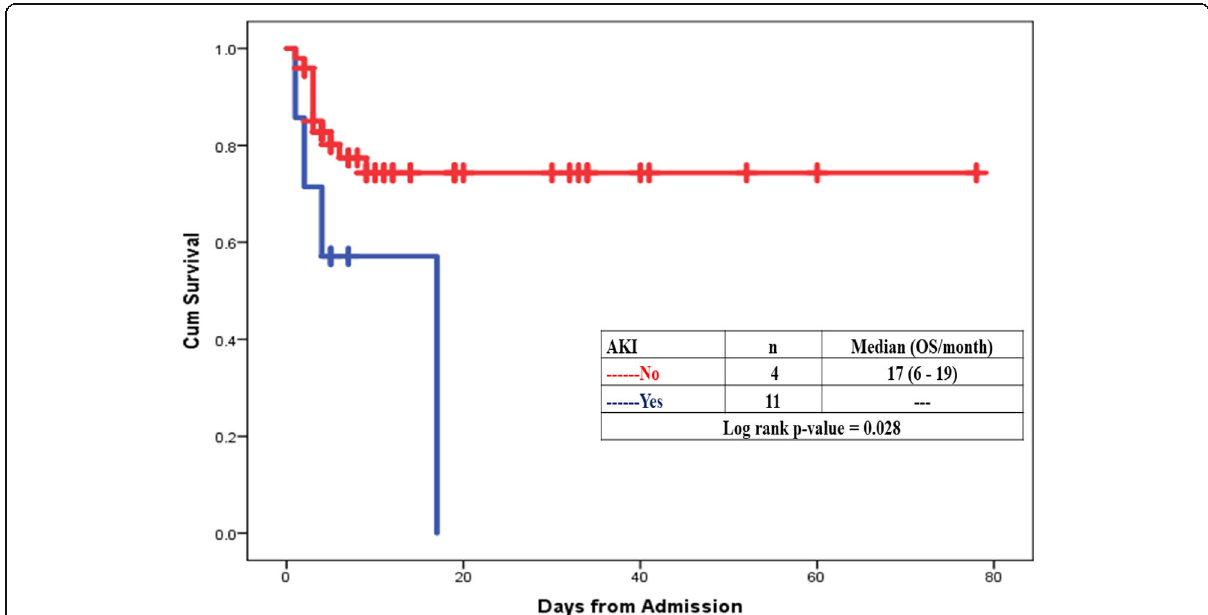
Fig. 4 Survival probability is lower in patients with AKI. The Kaplan-Meier survival curves for patients with and without AKI. Red line indicates patients without AKI, and blue line is for those with AKI. AKI patients were censored at 17 days. Patients who were discharged alive before 17 days were treated as still at risk and not censored at